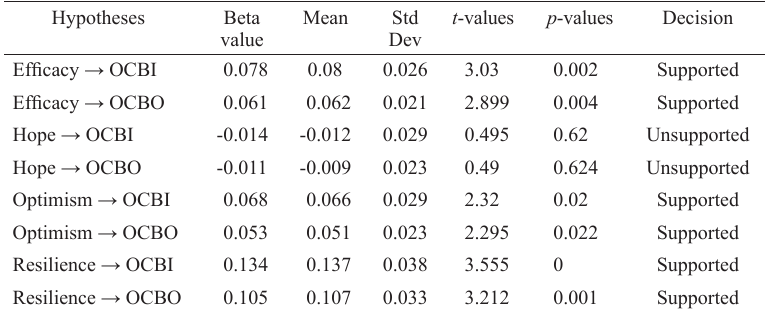
Analysis of the Path Coefficient (Direct